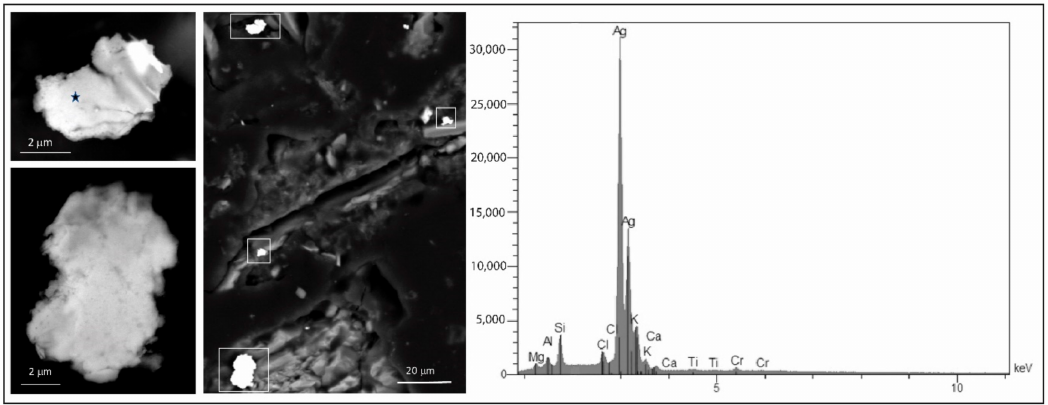
Figure 2. Particles of metallic Ag (white squares) in Adyar river sediment (scanning electron microscope